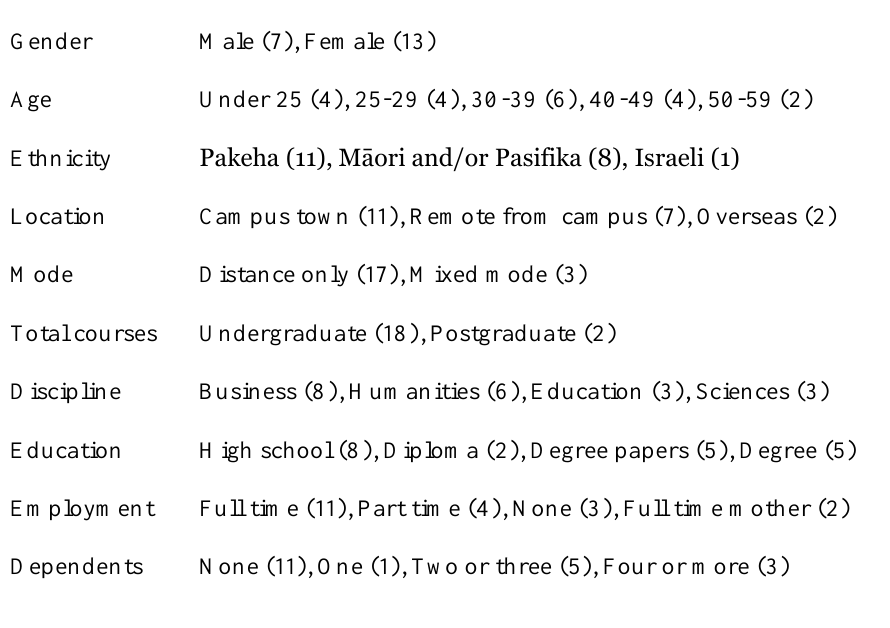
Summary of the participant